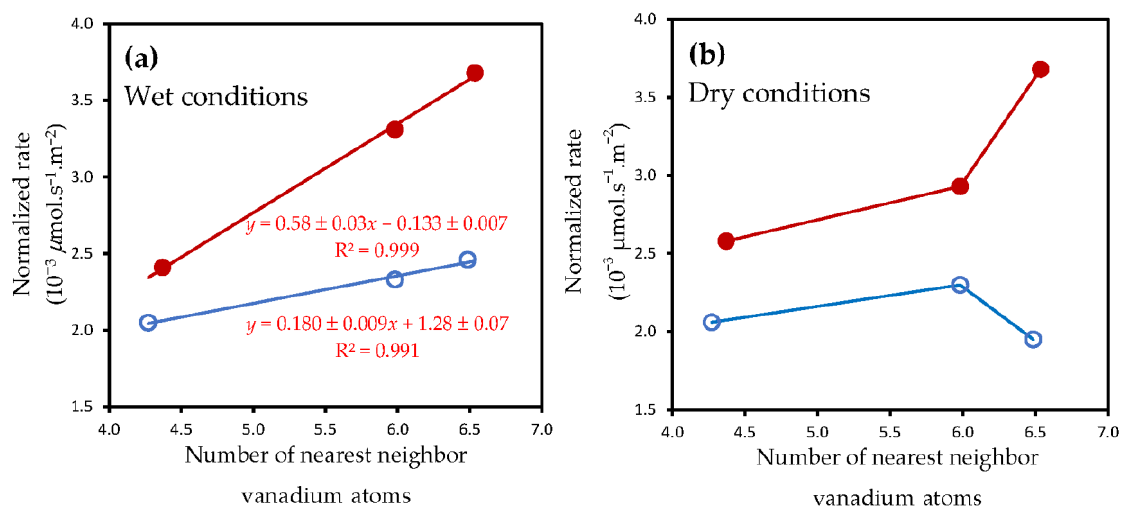
Figure 11. Dependency of the nearest vanadium atoms in VO x clusters on the normalized reaction rates measured on 2.1W- x V ( ) and 9.5W- x V ( • ) exposed at 160 ◦ C to 400 ppm NO, 400 ppm NH 3 , 8 vol.% O 2 in the presence ( a ) and in the absence of 10 vol.% H 2 O ( b ).